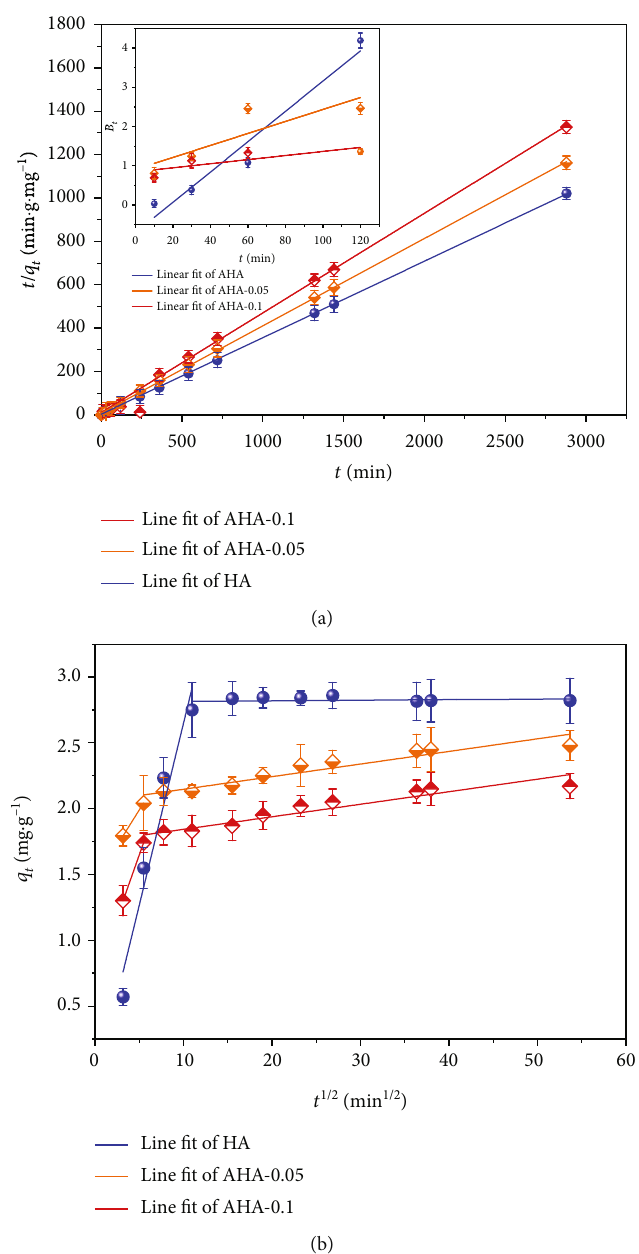
Figure 3: (a) The pseudo-second-order kinetic model fi tting the adsorption of TC onto HA, AHA-0.05 and AHA-0.1, respectively (insert is the e Boyd ’ s fi lm-di ff usion model fi tting the adsorption of TC onto HA, AHA-0.05 and AHA-0.1, respectively); (b) the Weber and Morris intraparticle di ff usion model fi tting the adsorption of TC onto HA, AHA-0.05, and AHA-0.1,